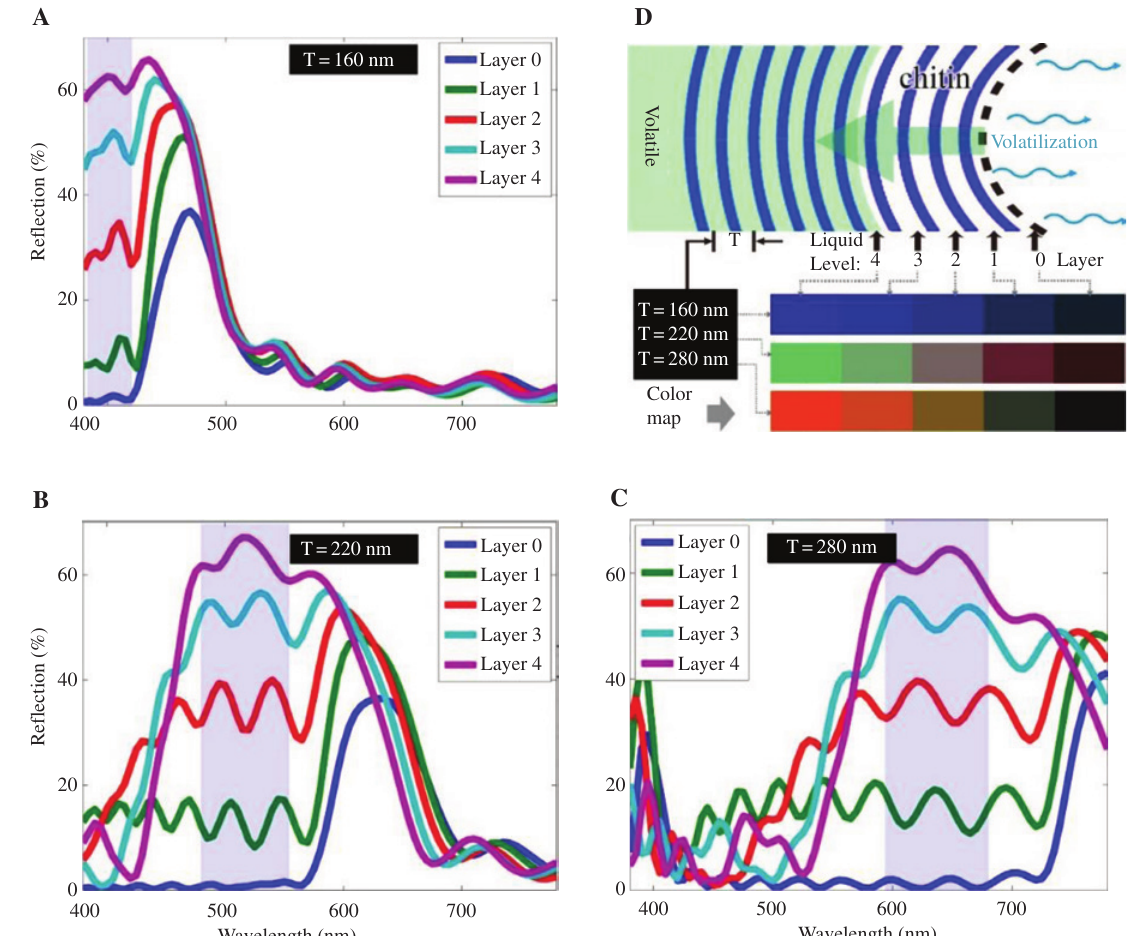
Figure 6: Computed reflectivity spectra show the effect of T (the period of periodic concave multilayer). (A, B, C) Reflectivity spectra with T = 160 nm, 220 nm, and 280 nm, layers 0–4: the liquid level of ethanol, as shown in (D). (D) Schematic plot of the model shows the vola- tilization of ethanol, the liquid levels are labeled as 0 to 4. The color map with T = 160 nm, 220 nm, and 280 nm was calculated from the corresponding